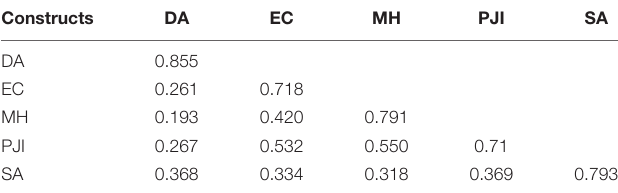
TABLE 3 | Discriminant validity.